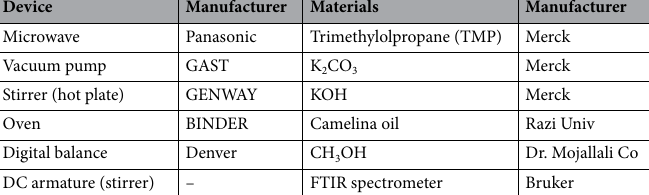
Table 2. The materials and equipment used in this